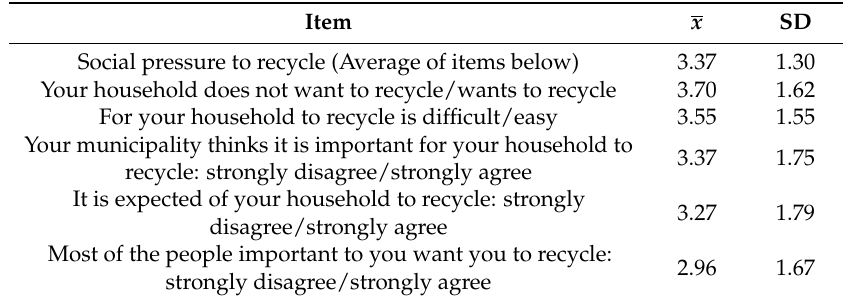
Table 5. Descriptive statistics for the subjective norm